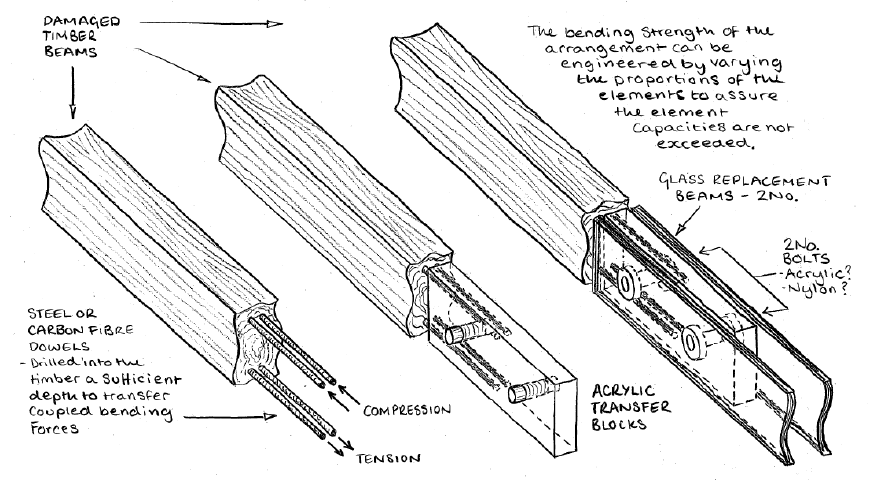
Figure 7: Splice Detail Between Restored Timber and Replacement Glass